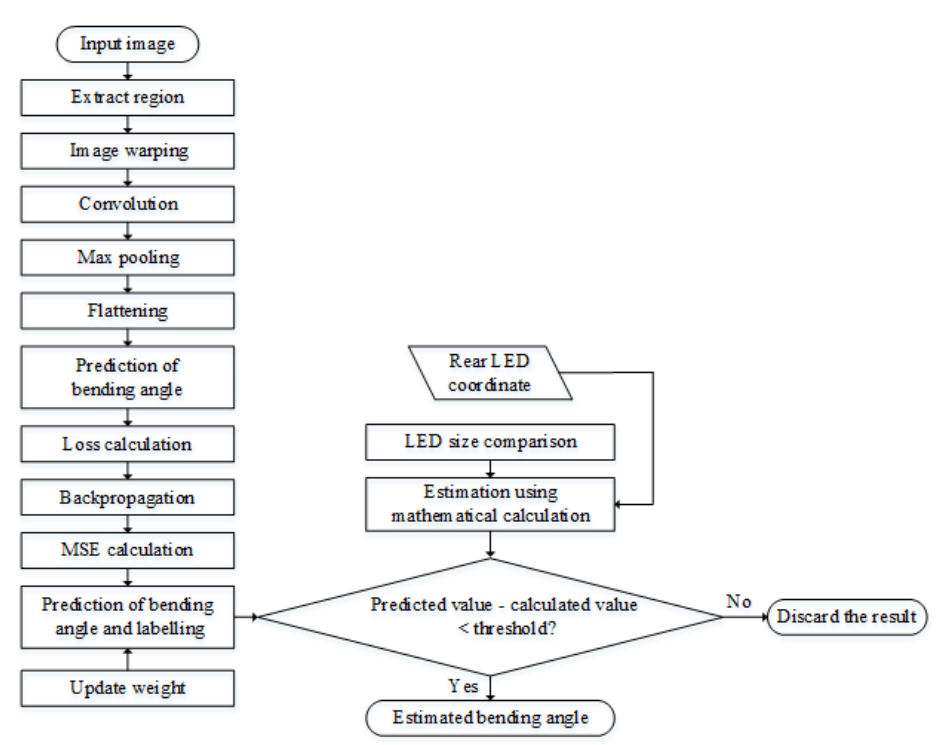
Figure 7. Flowchart of detection and measurement of road bending angle from LED